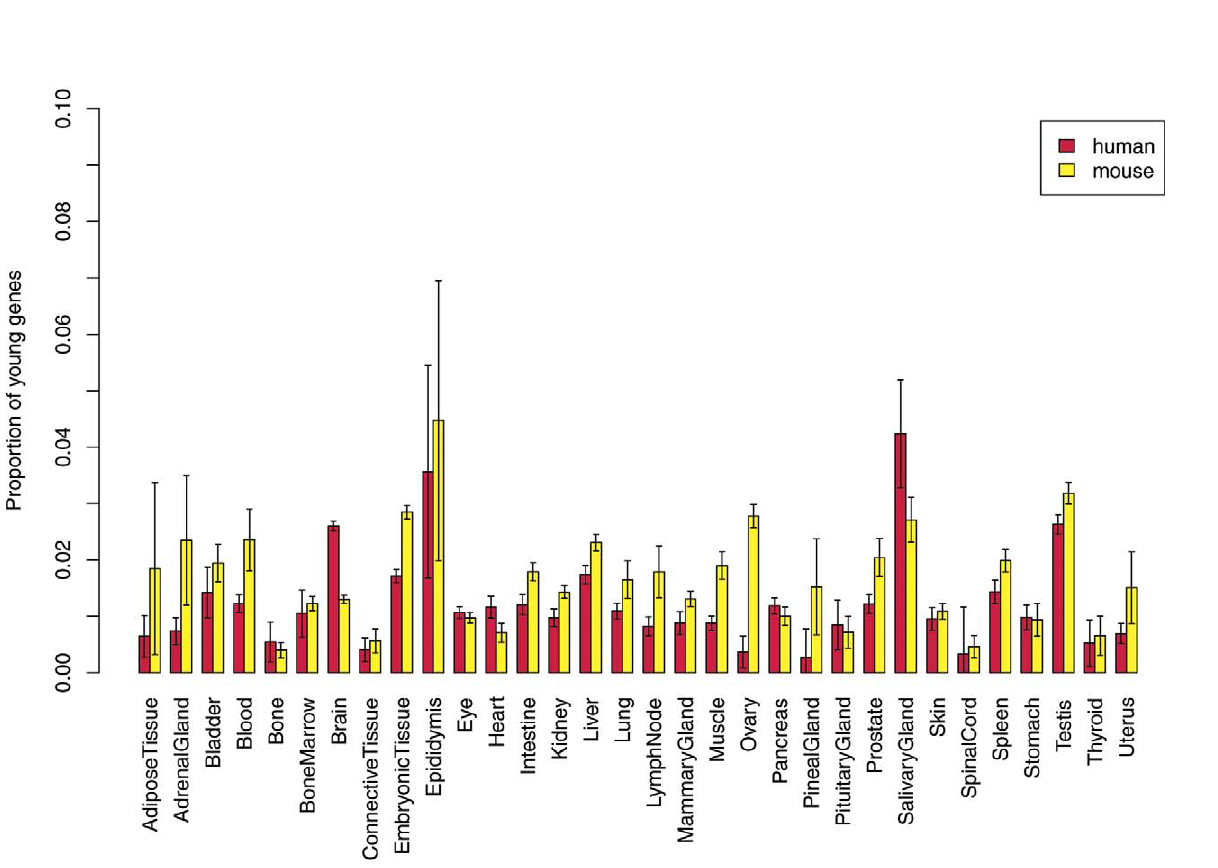
Figure 1. New gene contribution to various tissue transcriptomes. The barplot shows the proportion of young genes out of all genes expressed in tissue or organ categories shared by UniGene human and mouse. For each category, mean and 2-fold standard deviation were plotted, which were generated with 100 bootstrapping replicates of background EST data. Only the brain shows a significant excess of new human genes based on Fisher’s Exact Test (FET) with Bonferroni correction.